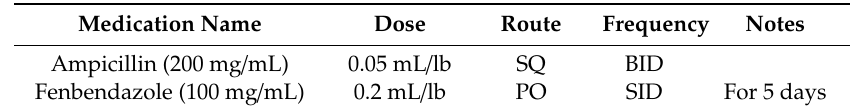
Table A4. Medications administered for ET treatment, their dose, route (subcutaneous, SQ; or oral, PO), and frequency (once a day, SID; twice a day, BID).